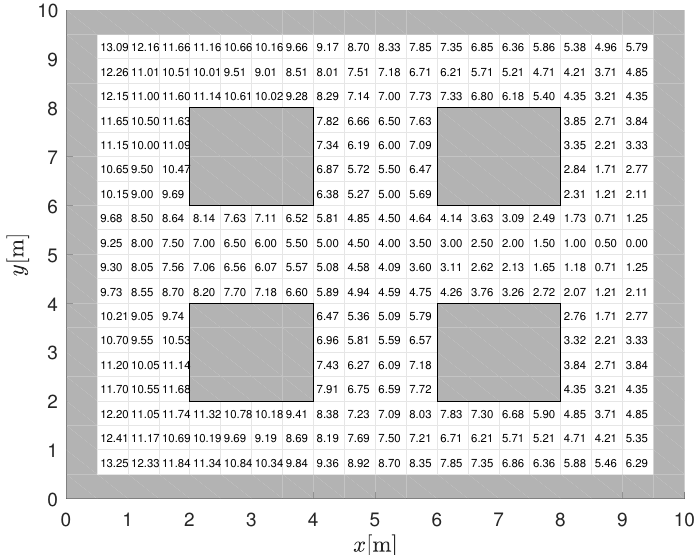
Figure 3. 3D view of the discrete potential function from obtained a grid-based search with 0.5 m resolution, a target position at x = 9.25 m, y = 5.25 m, and occupied cells with U ( x , y ) = ∞ (grey